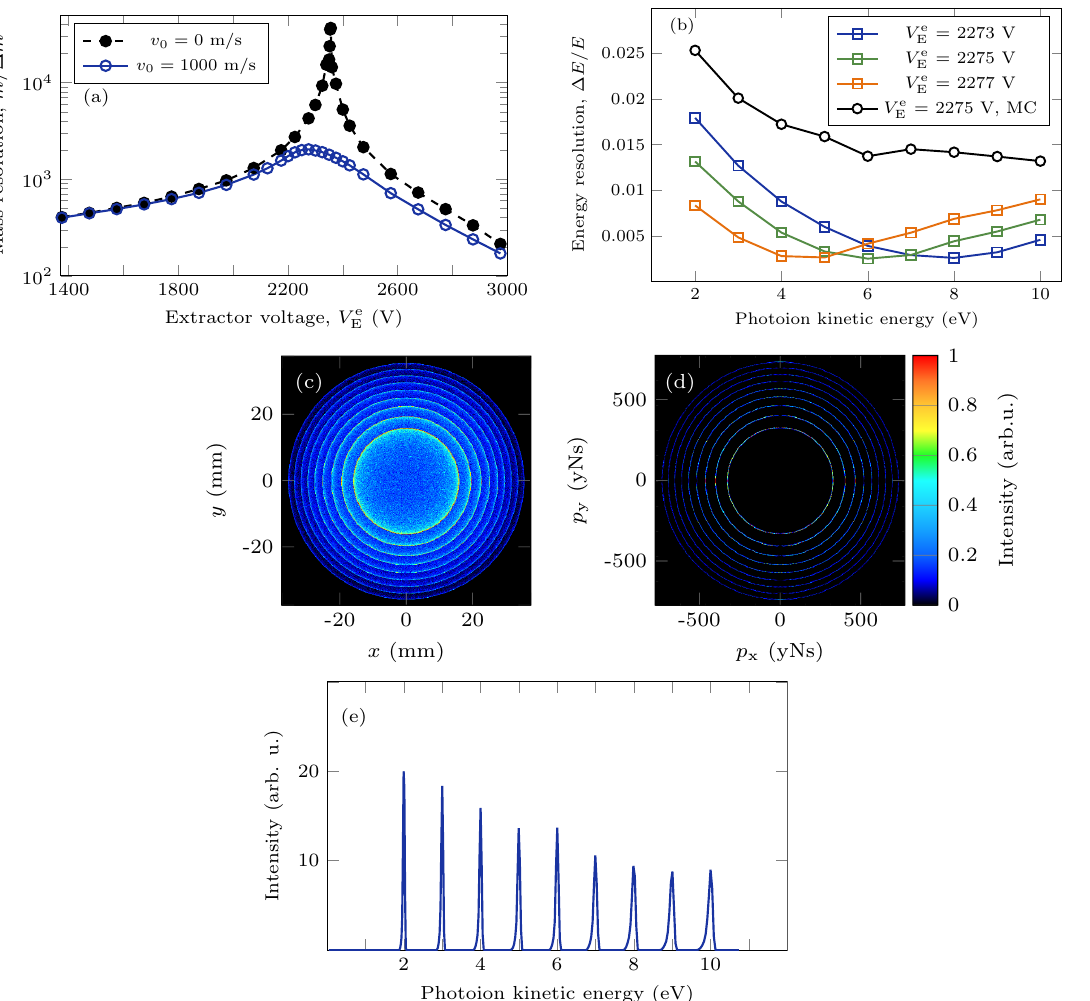
Figure 2. Simulation results for the high resolution ion modes. ( a ) shows the resulting mass resolution at mass m = 100 u as a function of extractor voltage, V e , for ions with zero initial kinetic energy E (black) and ions with an initial velocity of v 0 = 1000 m/s in the direction of the molecular beam (blue); ( b ) shows the resulting VMI energy resolution for three different extractor voltages ( V e ) using E the 27-particle model (blue, green and orange lines) and the Monte Carlo model for the optimum setting (black line); ( c , d ) show the simulated detector image and the 3D momentum distribution after inversion, for the optimum voltages; ( e ) shows the kinetic energy spectrum calculated from the 3D momentum